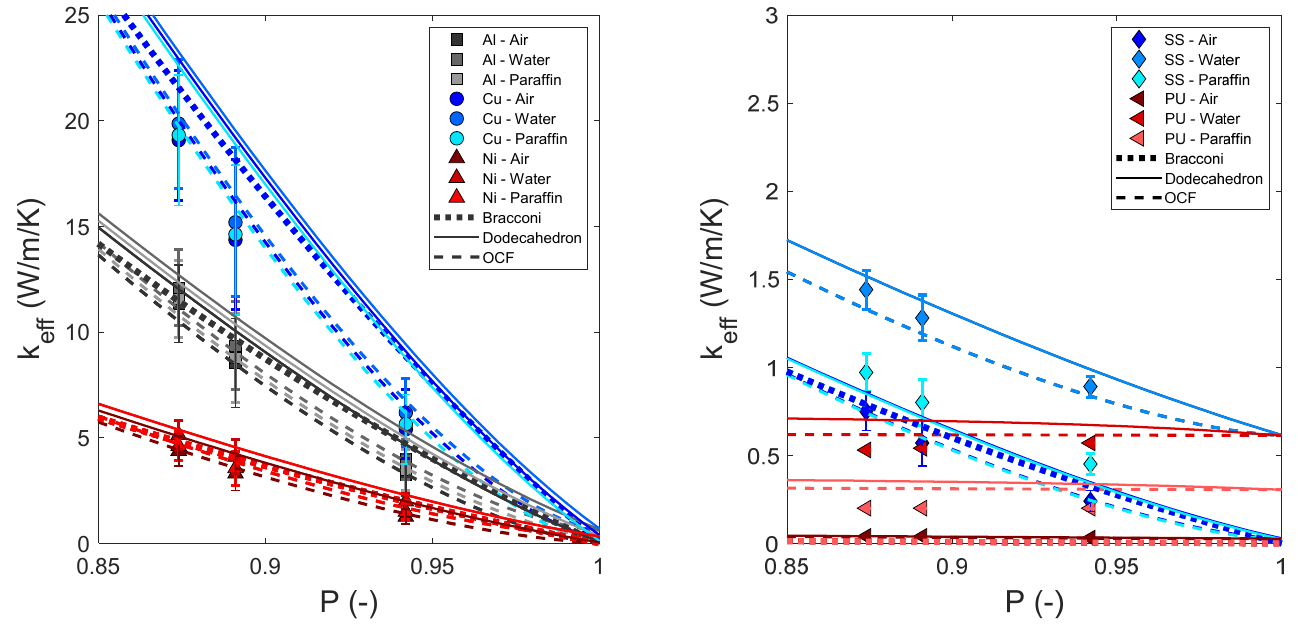
Figure 2. k eff estimated from Bracconi, dodecahedron and OCF relations compared with those from numerical simulations of Al, Cu and Ni foams ( left ) and SS and PU foams ( right ). The errors bars correspond to the standard deviation as reported by August et al. [19]. Lines from Bracconi’s relation are overlapping, as it does not consider the filling medium.